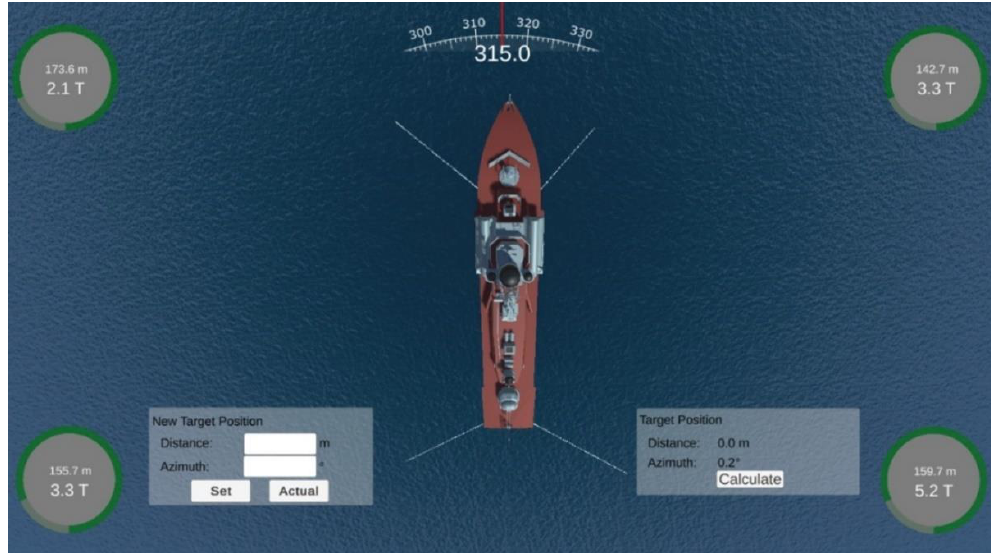
Figure 30. The anchorage in Unity3d.